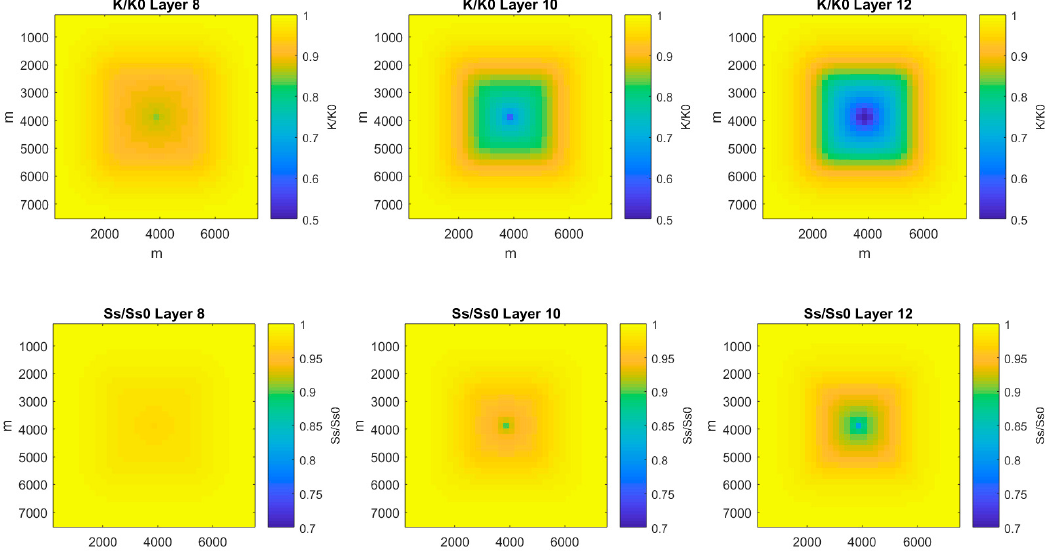
Figure 7. Change in hydraulic conductivity for different locations within the aquifer system.